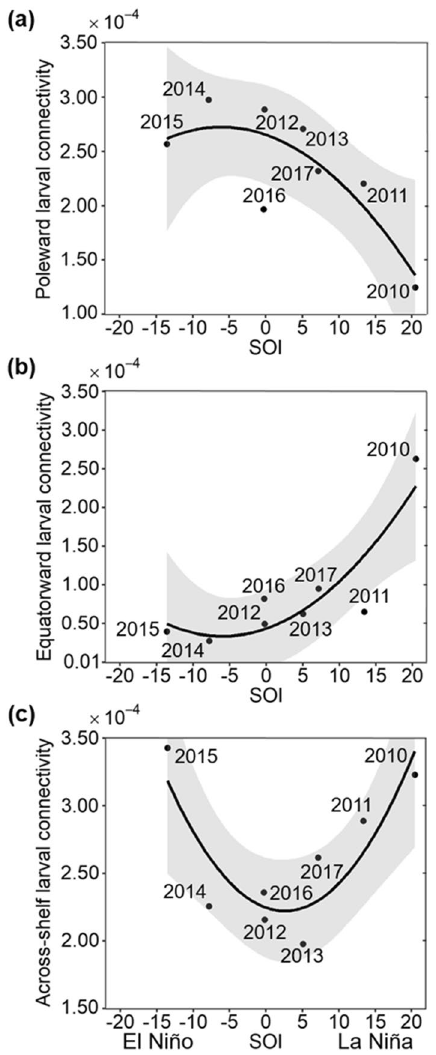
Figure 3. Relationship between interannual connectivity patterns for modelled L. carponotatus larvae in the central and southern GBR and the Southern Oscillation Index (SOI). Connectivity patterns are represented according to ( a ) poleward, ( b ) equatorward and ( c ) across-shelf connectivity probability values. Variables were averaged for each year from 2010 to 2017. The following ENSO events were identified: very strong 2010 La Niña, moderate 2011 La Niña, 2014 El Niño alert and strong 2015 El Niño (during 2012, 2013, 2016 and 2017 a mix of neutral and La Niña conditions prevailed). Grey shaded areas show 95% confidence intervals of the connectivity means. All relationships (r 2 ) were statistically significant at a P <